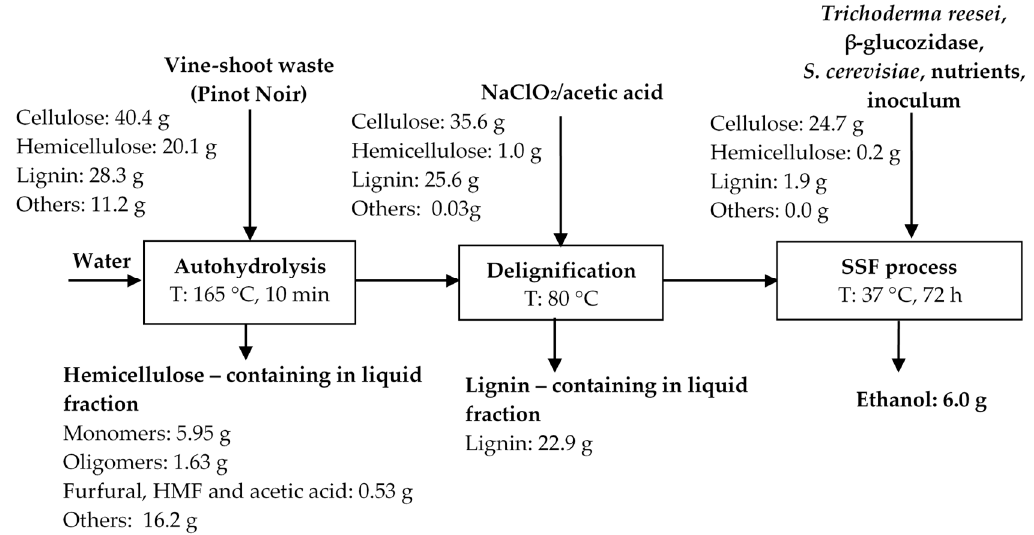
Figure 9. Material balance for bioethanol production from Pinot Noir variety of vine-shoot waste.